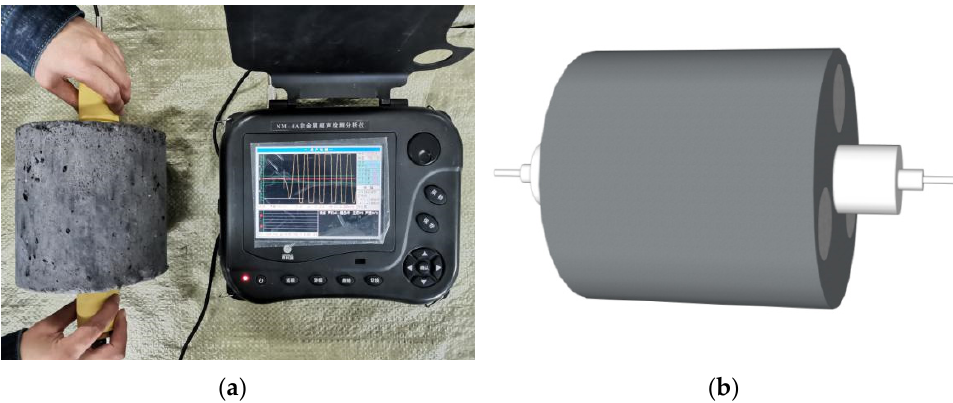
Figure 6. ( a ) Ultrasonic test and ( b ) simulation diagram of the ultrasonic test.